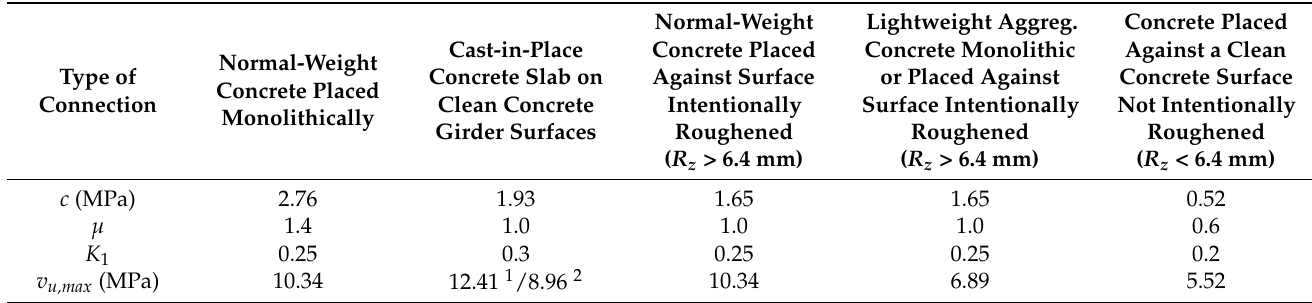
Table 4. Coefficients corresponding to various interface conditions according to AASHTO [35].